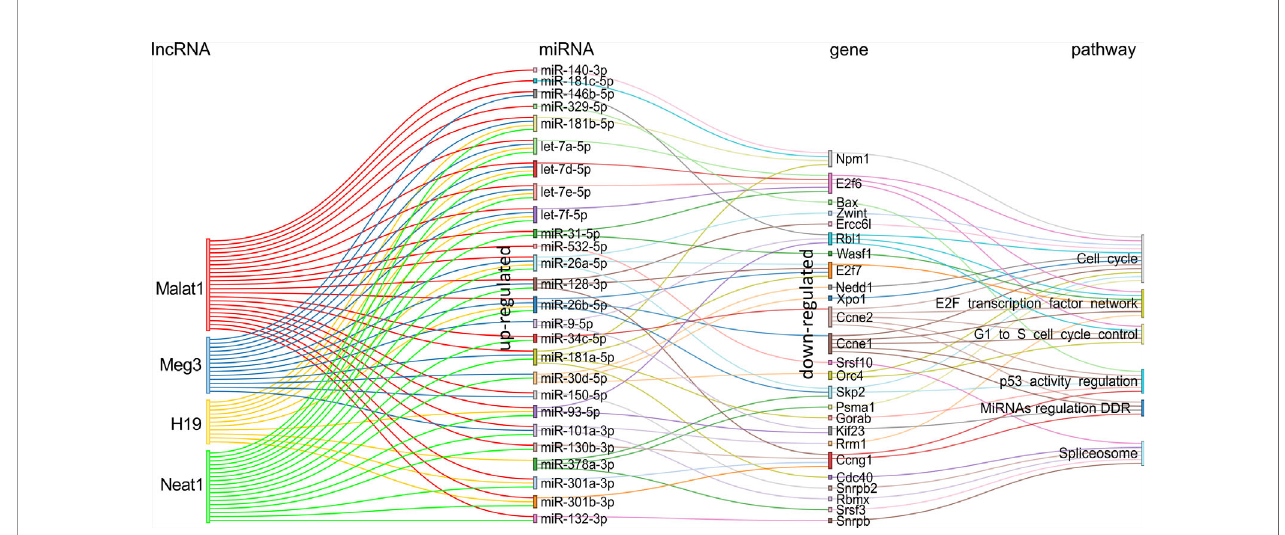
FIGURE 8 | Schematic representation of the experimentally supported triad lncRNA-miRNA-gene and the pathways in which the later are involved for the comparison KSHV ( − ) tumor vs KSHV (+) tumor. Pairs lncRNA-miRNA were identi fi ed only for the up-modulated